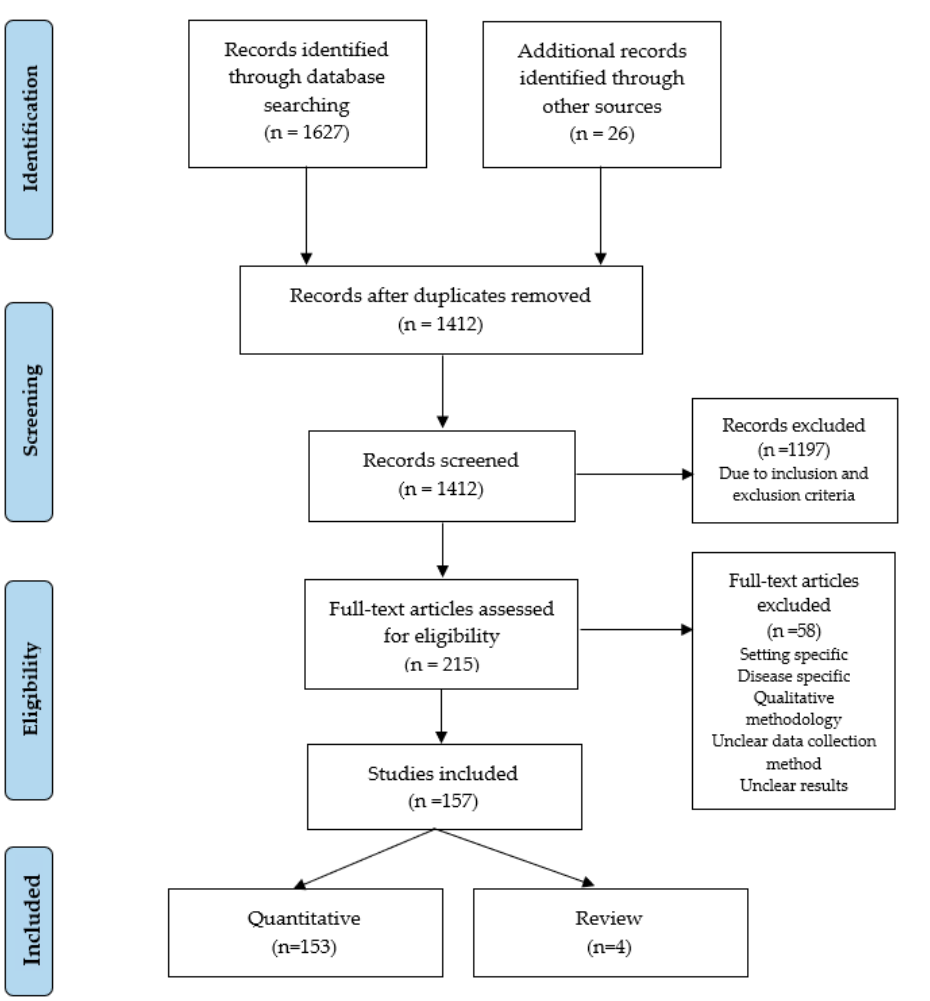
Figure 1. PRISMA statement.